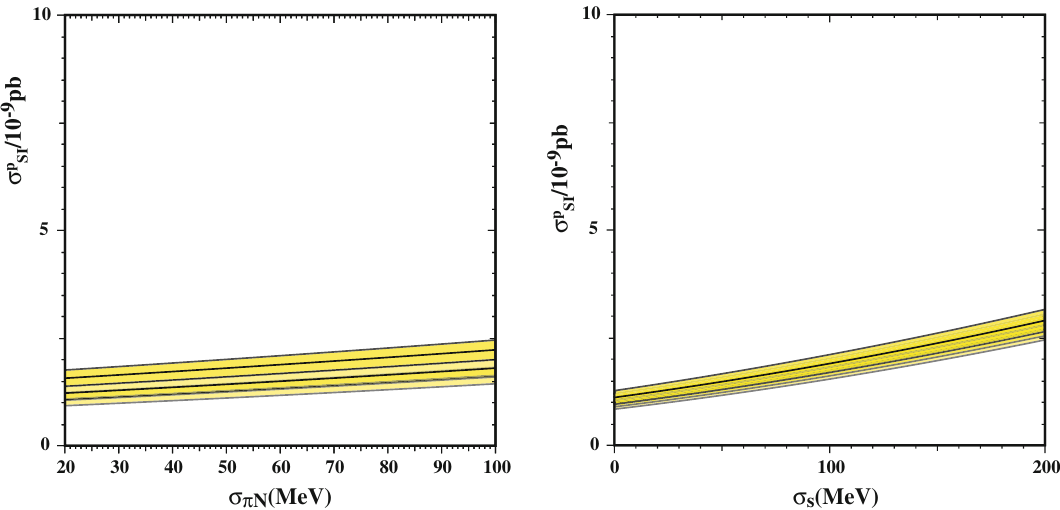
vs σ s for (cid:7) π N = 40 , 50 , 60 MeV. The color bands show the calculated 1 σ SI